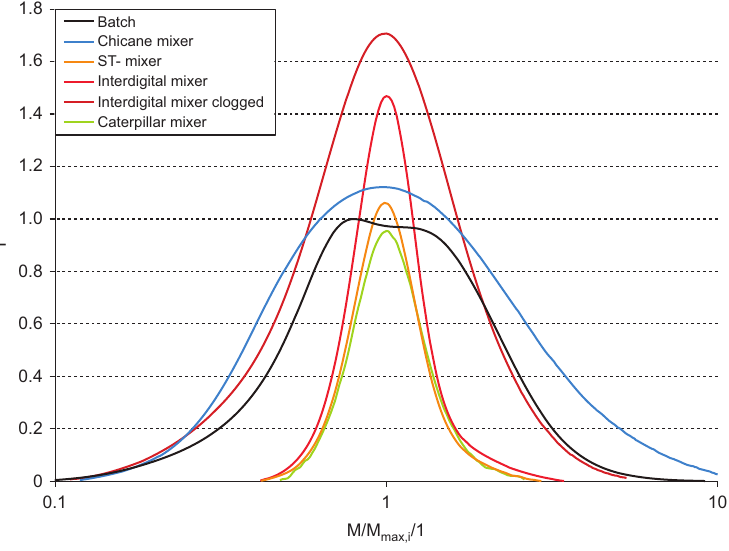
Figure 11 Normalised results from size-exclusion chromatography (SEC) for four investigated micromixers. The molar mass M is nor- . The intensity I of the signal is plotted as measured. A number-average molecular weight of malised to the most frequent molar mass M max 3000 g/mol was targeted. Achieved values of all samples were between 3000 and 6000